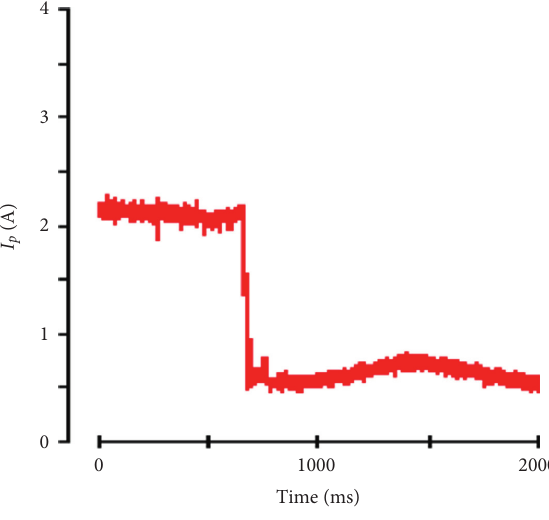
Figure 34: Evolution of temperature.